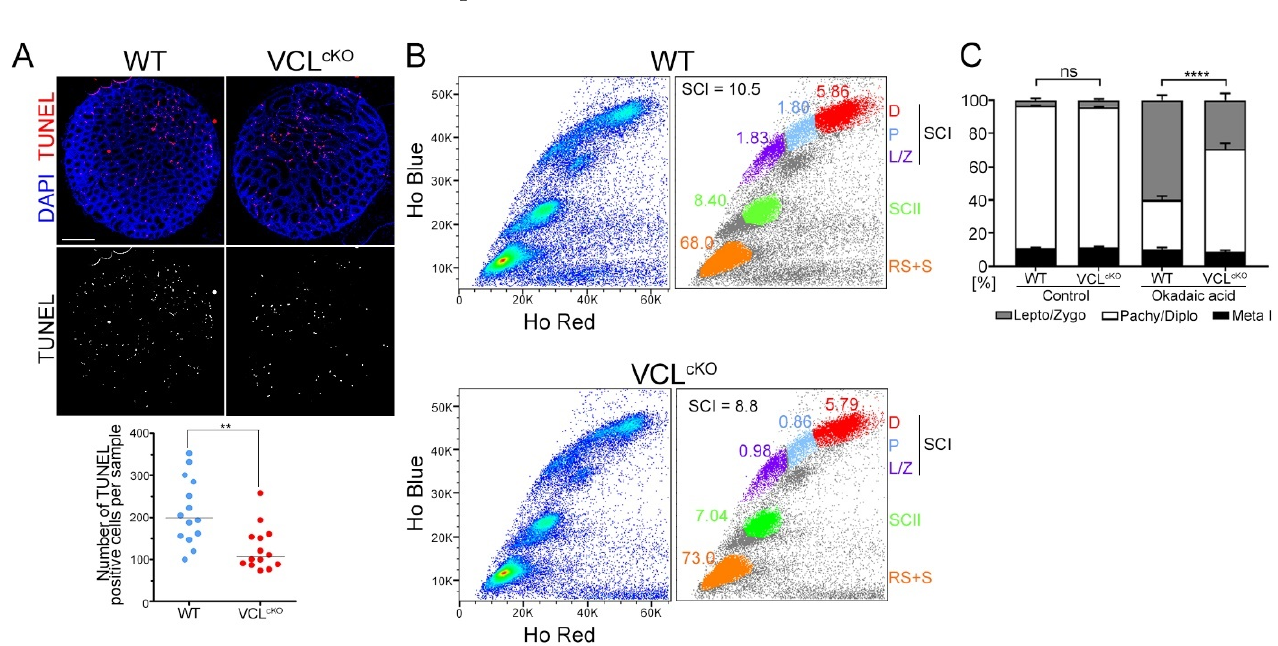
Figure 7. In VCL-depleted testes, spermatocytes underwent meiotic arrest; ( A ) TUNEL assay on the testes sections of WT and VCL cKO testes showing TUNEL-positive cells, i.e., apoptotic cells. We stained 12–15 testes sections with an ApoTag detection kit. The number of red foci (i.e., apoptotic cells) was counted. In the graph below, the number of foci of each testes section is depicted, with an assigned median value. Statistical evaluation involved an unpaired t -test, where ** is 0.0016; ( B ) testicular single-cell suspension stained with Hoechst-33342 in two distinct channels classified populations of cells into primary spermatocytes (SCIs), secondary spermatocytes (SCIIs, green), and round spermatids and sperm (n, orange). SCI is composed of three subpopulations: mixed leptotene/zygotene (L/Z, purple), pachytene (P, light blue), and diplotene (D, red). In the right panel, the SCI value indicates the percentage of SCI from all cells. The VCL cKO sample contains fewer SCI. The decrease was apparent in the L/Z (WT = 1.83% to VCL cKO = 0.98%) and P (WT = 1.80% to VCL cKO = 0.86 %) subpopulations, but not in D (WT = 5.86% to VCL cKO = 5.79%). Prophase I arrest affected the count of SCIIs (WT = 8.40% to VCL cKO = 7.04%); ( C ) A short-term culture of VCL cKO and control spermatocytes was treated with okadaic acid (OA) at 5 mM concentration and incubated for six hours. Quantification of G2/MI transition revealed a progression of 60.02% of prophase I spermatocytes to diakinesis/prometaphase I in the treated WT culture. Progression of only 29.41% of pachytene/diplotene spermatocytes was observed in the treated VCL cKO culture. The p -value represents a comparison of progression to metaphase I (chi-squared test) between the control and VCL cKO . No treatment, ns = 0.7517; OA treatment, **** < 0.0001. Error bars show the mean ±